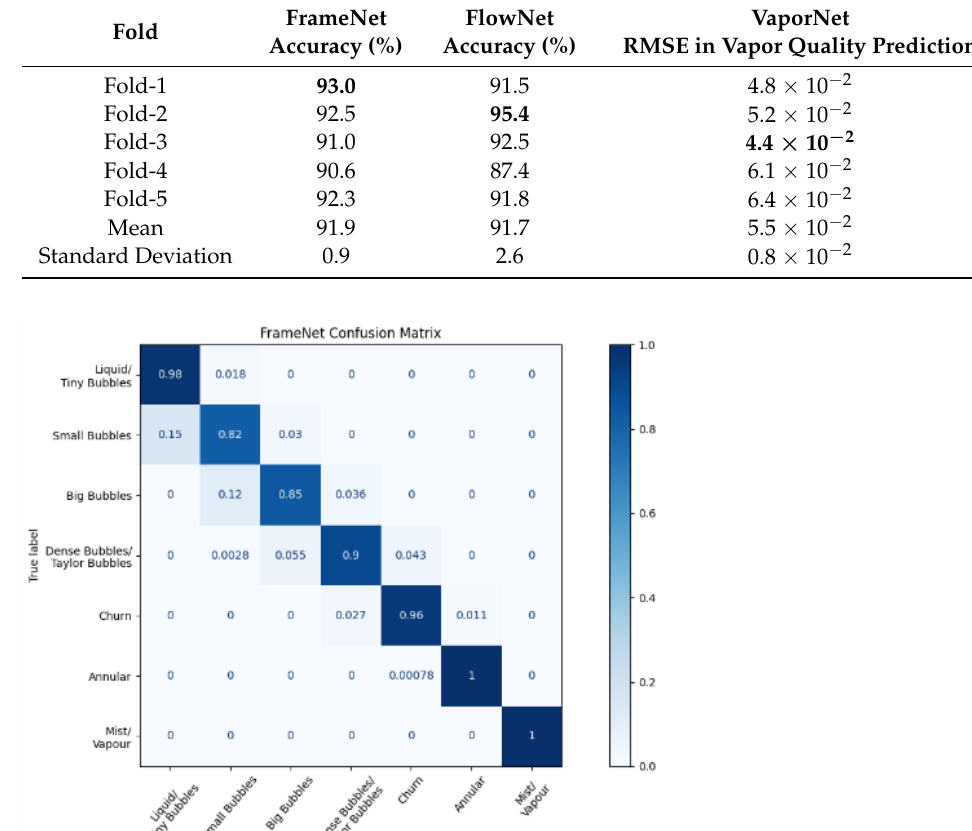
Figure 6. Normalized confusion matrix for FrameNet.